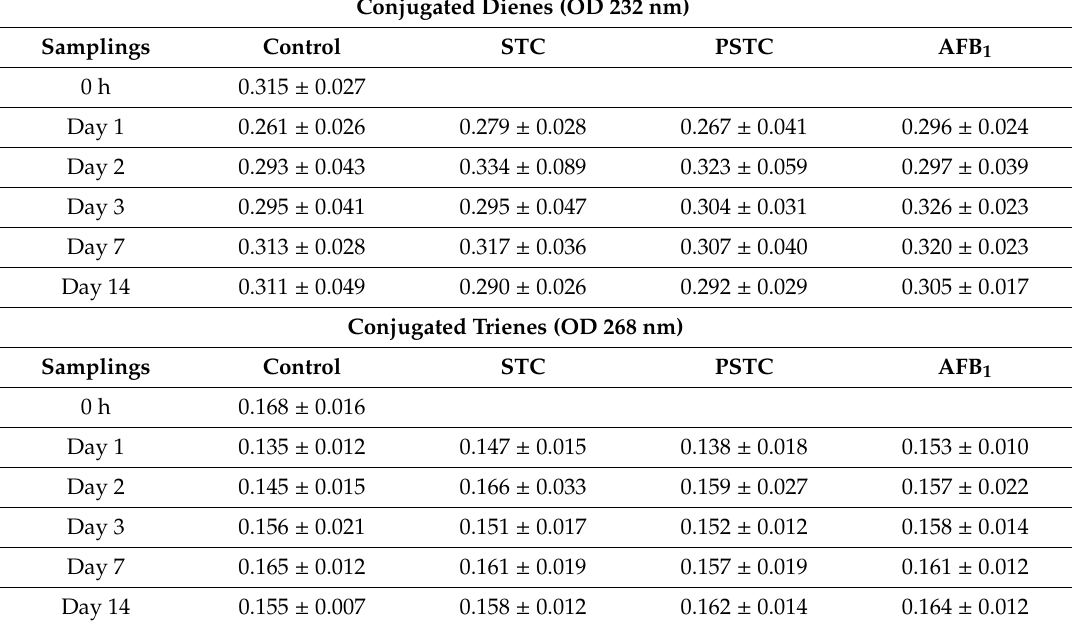
Table 4. E ff ect of sterigmatocystin and aflatoxin on conjugated dienes (CD), trienes (CT) and thiobarbituric acid reactive substances (TBARS) contents in the liver of broiler chickens (mean ± SD, n =